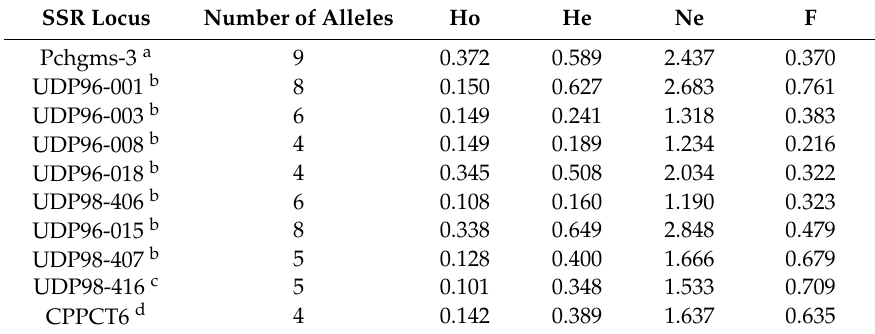
Table 1. Number of alleles per locus, observed (H o ) and expected (H e ) heterozygosities, e ff ective number ofalleles(N e ), andWright’sfixationindex(F)of148peachgenotypesusing10SSRmicrosatellitemarkers. SSR Locus Number of Alleles Ho He Ne F Pchgms-3 a 9 0.372 0.589 2.437 0.370 UDP96-001 b 8 0.150 0.627 2.683 0.761 UDP96-003 b 6 0.149 0.241 1.318 0.383 UDP96-008 b 4 0.149 0.189 1.234 0.216 UDP96-018 b 4 0.345 0.508 2.034 0.322 UDP98-406 b 6 0.108 0.160 1.190 0.323 UDP96-015 b 8 0.338 0.649 2.848 0.479 UDP98-407 b 5 0.128 0.400 0.679 UDP98-416